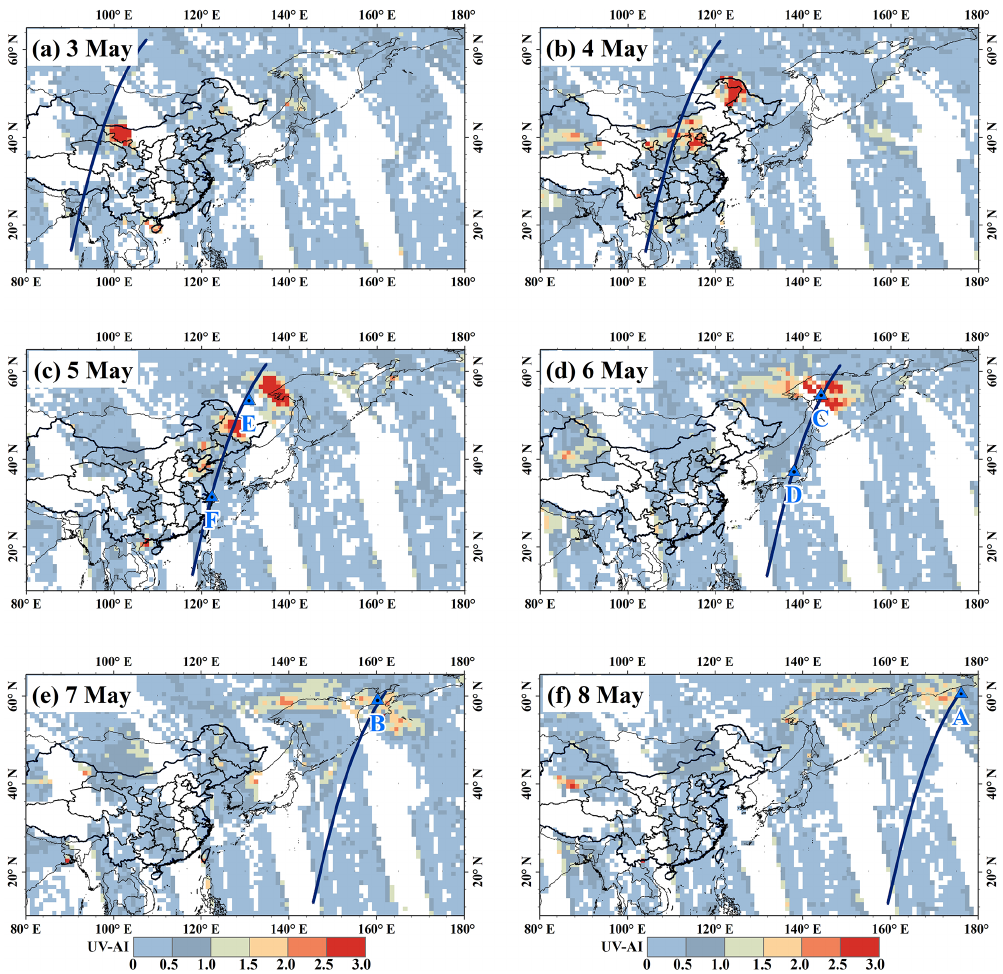
Figure 2. (a) – (f) Spatial distributions of the OMI UV-AI from 3 to 8 May 2017. The deep blue lines are the overpass trajectories of the CALIPSO observations used on that day. The blue triangles are the end points of the HYSPLIT